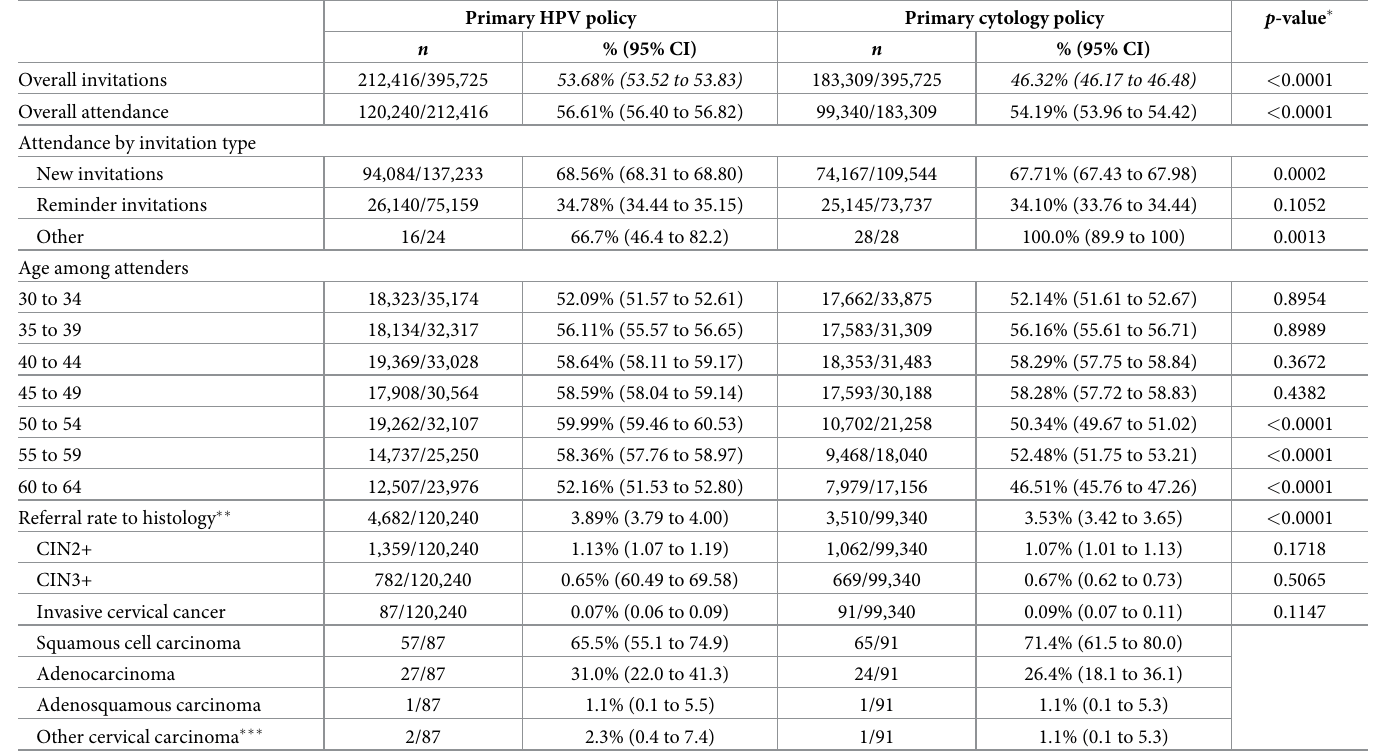
Table 2. Overall invitations, attendance, and referral to histology by study arm (ITS